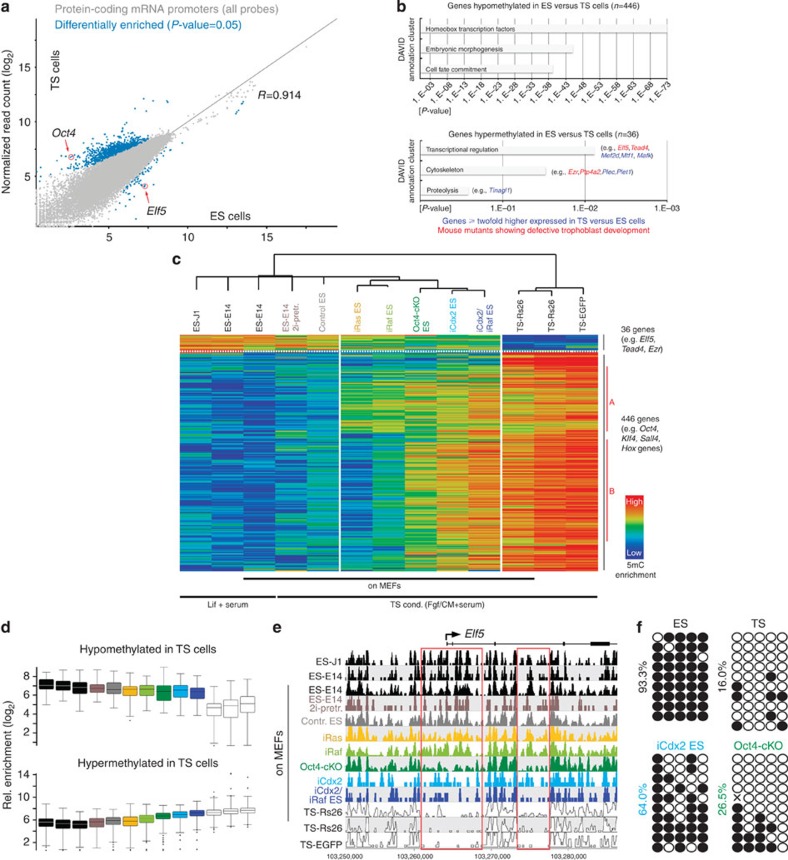
Epigenomic reprogramming dynamics of DNA methylation in TSL models.(a) Scatter plot of meDIP-seq replica sets of two independent ES and TS cell lines each identified 482 signature loci that are differentially methylated between the two stem cell types. Each dot represents a 5-kb probe located in a 10-kb region centred on transcription start sites (using three overlapping 5 kb probes with 2.5 kb step size). Blue dots correspond to differentially enriched probes. (b) Functional annotation and classification of genes identified in (a) that are either hypo- or hypermethylated in ES versus TS cells. In red are genes whose mouse mutants show defective trophoblast development according to the MGI database. In blue are genes found to be more than twofold higher expressed in TS versus ES cells37. (c) Heatmap and neighbour joining tree based on a Pearson’s correlation distance matrix of the DNA methylation levels at the 482 signature loci. Subcluster ‘A’ identifies genes that gain methylation in all reprogramming models, including upon Ras/Raf activation, whereas subcluster ‘B’ identifies loci that become significantly reprogrammed only upon modulation of transcription factors. (d) Box whisker plots of the progression of methylation reprogramming in the various TSL models, compared with ES and TS cells. This representation visualizes that the major roadblock to reprogramming is the failure to demethylate trophoblast-specific ‘gatekeeper’ genes. In comparison, the gain of methylation is generally more comprehensively achieved. (e) Distribution of DNA methylation at the Elf5 locus in all TSL models. Red boxes indicate important regulatory regions where this lack of complete demethylation reprogramming is exemplified. (f) Bisulphite-sequencing profiles of the Elf5 promoter; the observed DNA methylation levels were in agreement with those determined by meDIP-seq.